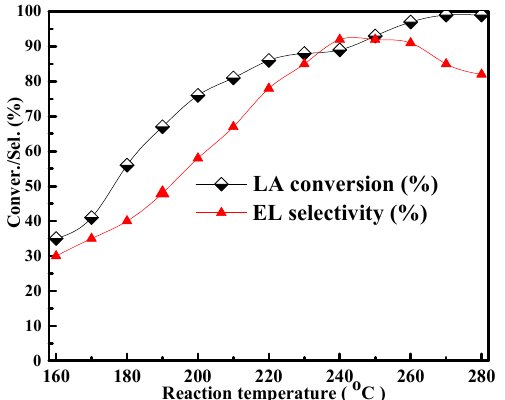
Figure 5. Effect of temperature on esterification of LA with ethanol over Pt/STA-ZrO 2 catalyst.